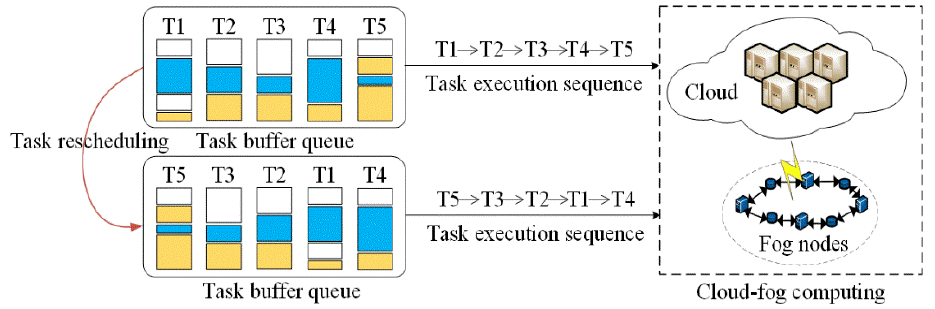
Figure 4. Rescheduling process based on the order of task priority.